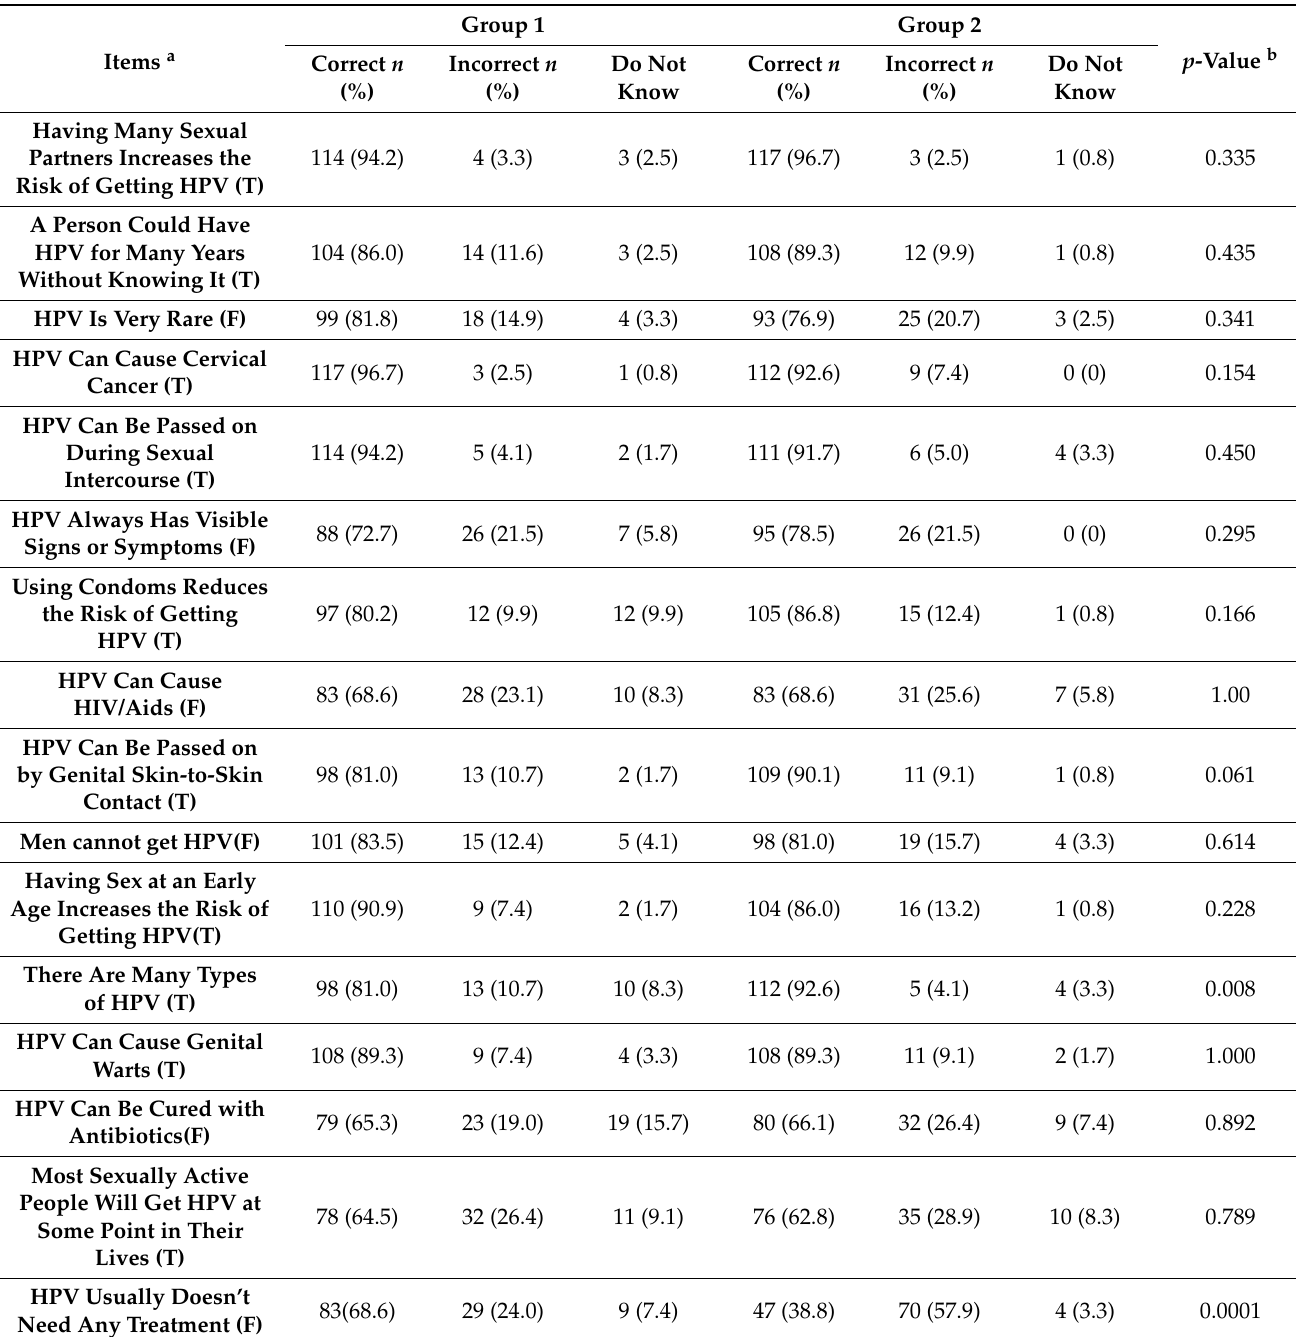
Table 3. Comparison of general HPV knowledge after receiving the intervention between the two